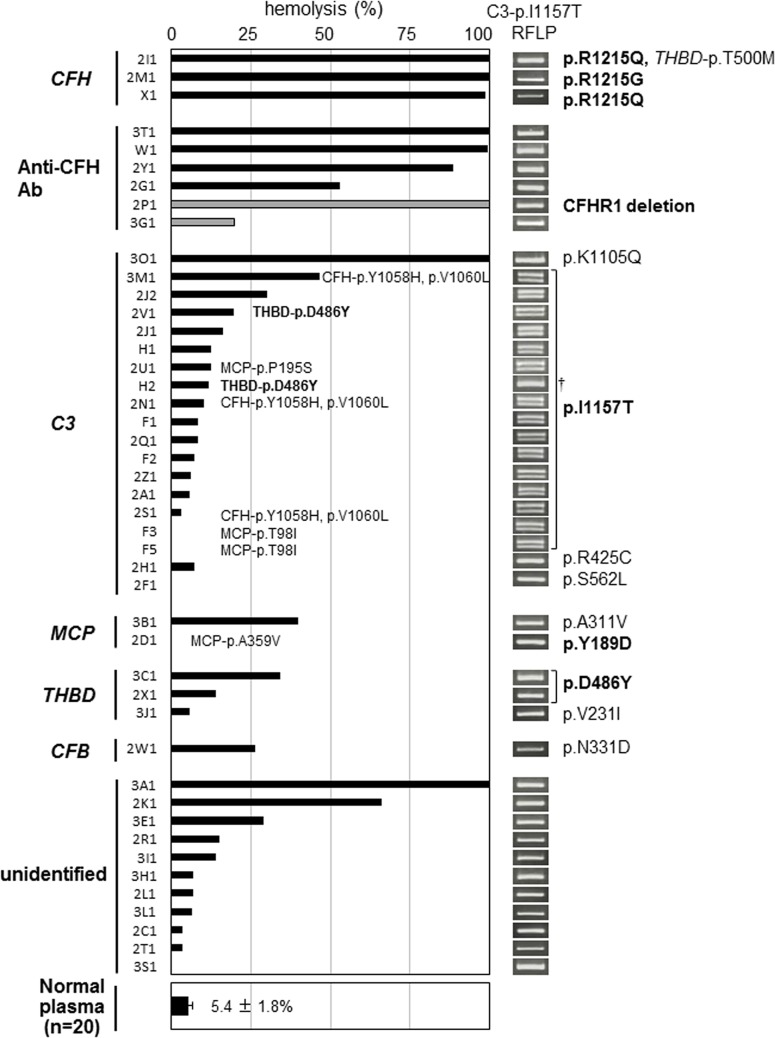
Relationship between hemolytic activity and complement abnormalities in 45 patients with atypical hemolytic uremic syndrome (aHUS).The results of the hemolytic assay for 45 aHUS patients are shown according to the predisposing (bold type) or potentially predisposing mutations and/or the acquired abnormalities. The patients carrying two mutations were classified according to the predisposing mutation, and the other mutations were described alongside the predisposing mutations or black bars. Two patients (2V1 and H2) were categorized into the C3 group, although they had two predisposing mutations (C3-p.I1157T and THBD-p.D486Y). In two patients (2P1 and 3G1), the hemolysis induced by serum was represented by gray bars. The normal range of hemolysis (5.4±1.8%: mean ± standard deviation) obtained from 20 healthy individuals (10 males and 10 females) is shown at the bottom of Fig 3. The results of the restriction fragment length polymorphism (RFLP) analysis of C3-p.I1157T are summarized to the right of the hemolytic assay results. Regarding the RFLP analysis of C3-p.I1157T (c.3470T>C), the heterozygous mutation (T/C) showed two bands (278 bp, 314 bp) and the homozygous mutation (C/C) showed one band (314 bp). † H2 had a homozygous mutation in C3-p.I1157T.